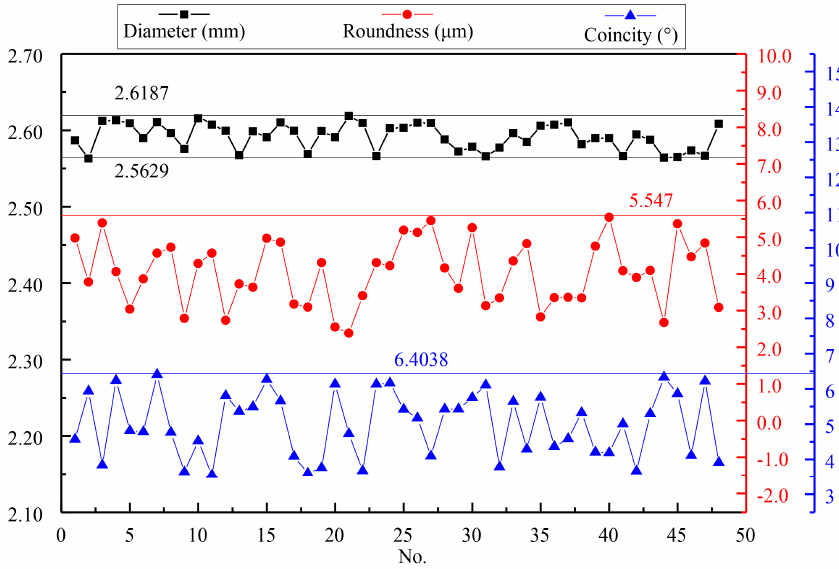
Figure 12. The measured results of the hole array structure.